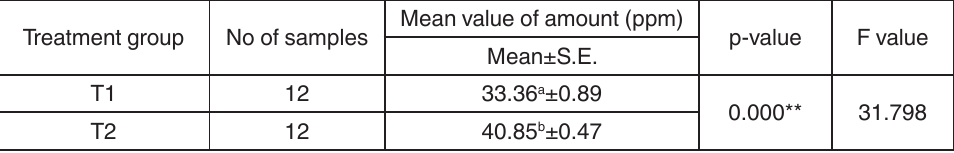
table 2: Mean value of zinc concentration (mg/L (ppm)) in eggs of different treatment groups Treatment